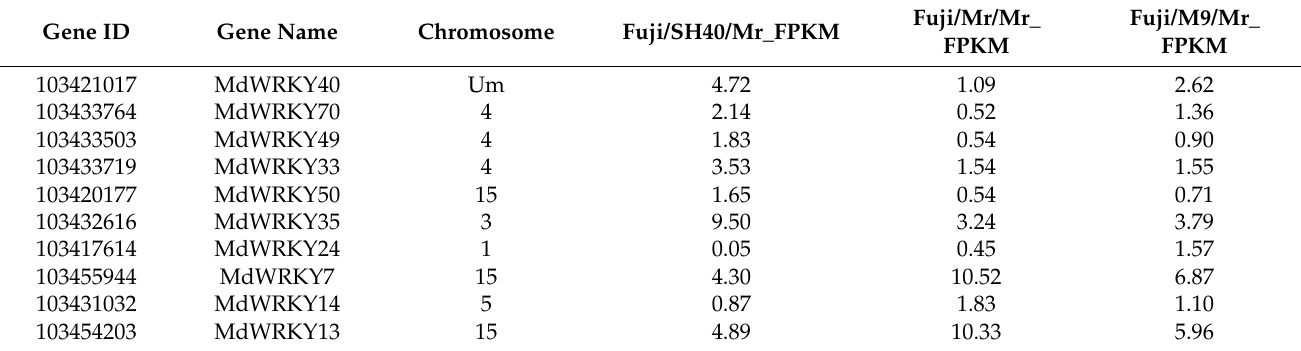
Table 1. Significantly differentially expressed MdWRKY TFs with different interstocks.